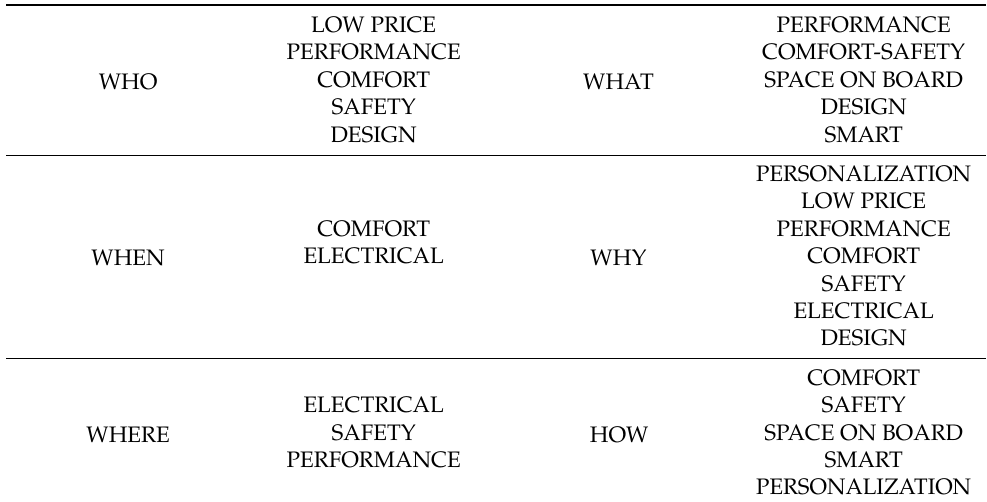
Table 2. Six questions applied to the presented case